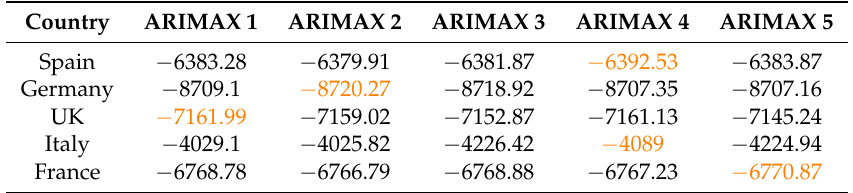
Table 10. AIC for all model and countries for modelling volatility proxy of mean